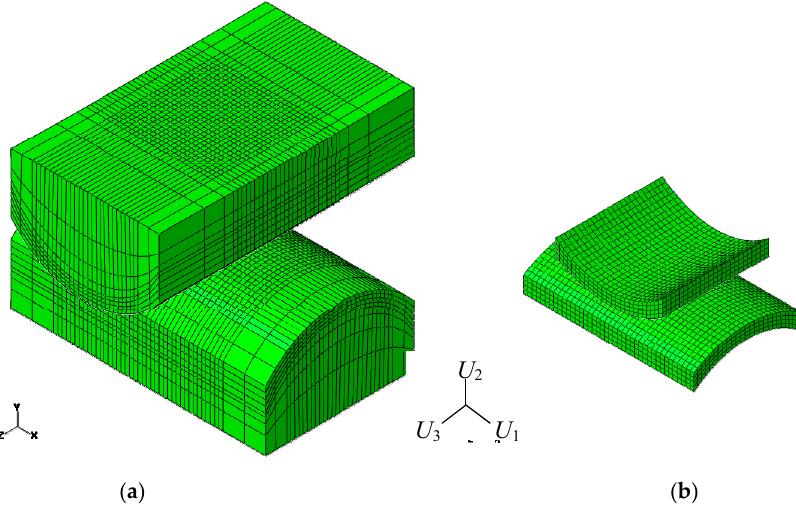
Figure 5. FE model consisting of C3D8 elements: ( a ) complete model; ( b ) closed-up view of the refined mesh at the contact region.